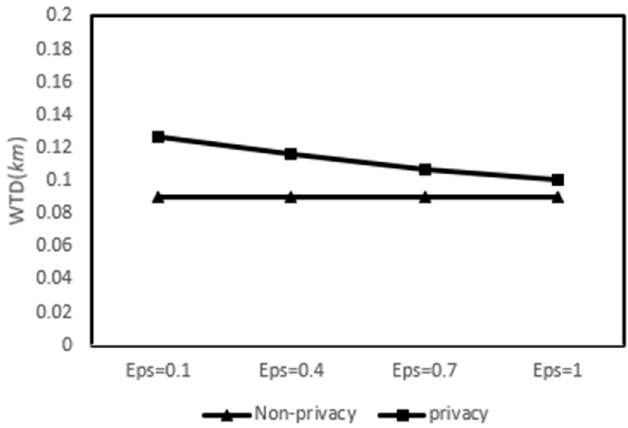
Figure 4. Worker travel distance (WTD) of non-privacy framework and our privacy framework.